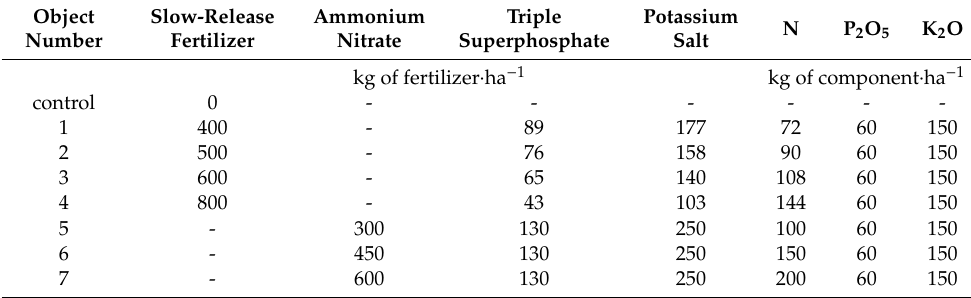
Table 2. Experiment